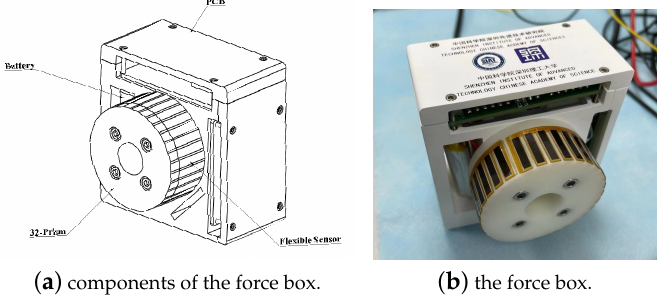
( a ) components of the force box. ( b ) the force box. Figure 4. The structure of the force box, which can measure the tactile force exerted by the sur- geon’s fingers. The force value will be used as parts of multi-modal information to optimize the control